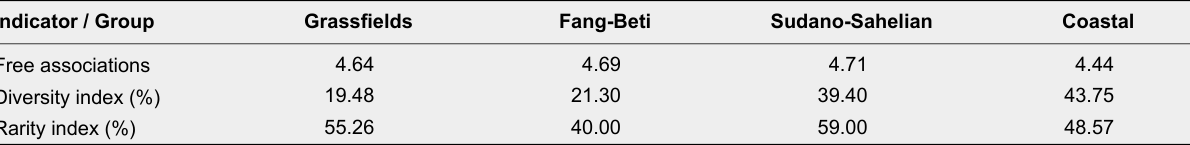
CoastalSudano-SahelianFang-BetiGrassfieldsIndicator /